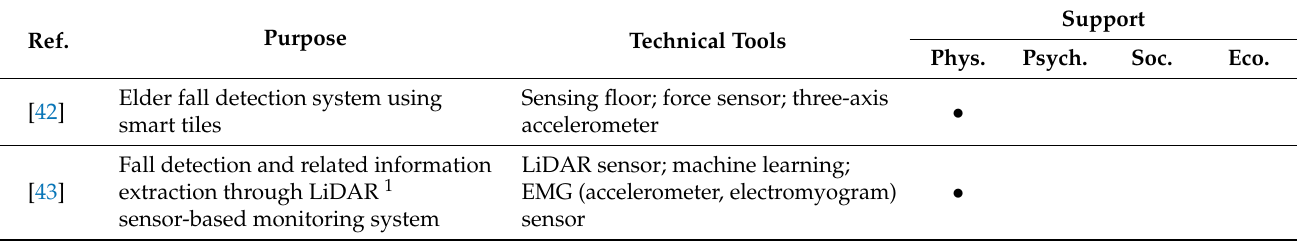
Table 1. Review of previous studies related to smart homes for the elderly. Technical Tools